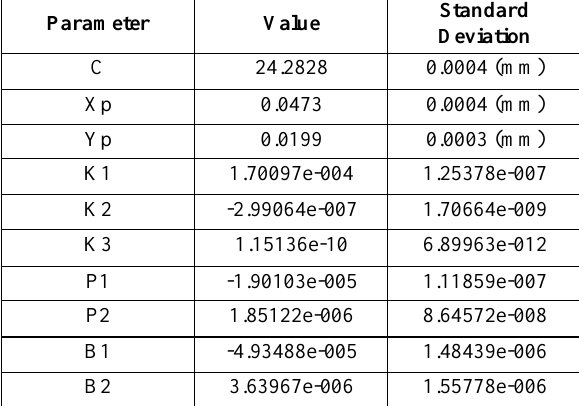
Table 1. Camera parameter resulted from indoor camera